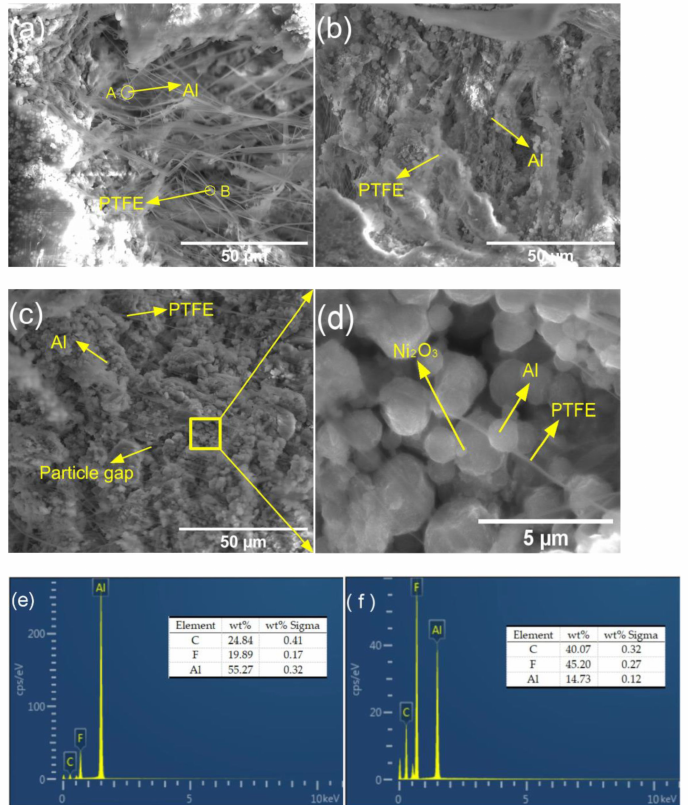
Figure 6. The fracture morphology of different reactive materials after quasi-static compression. ( a ) PTFE/Al; ( b ) PTFE/Al/CuO; ( c ) PTFE/Al/Ni 2 O 3 ; ( d ) Local magnification view of ( c ); ( e ) SEM at A point of ( a ); ( f ) SEM at B point of ( a